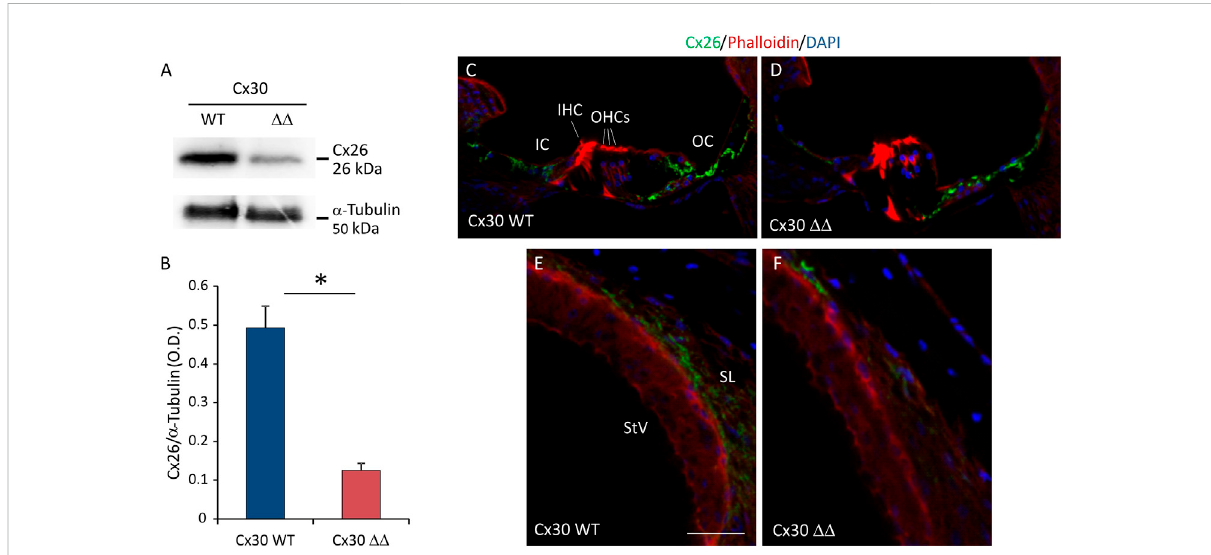
FIGURE 3 Cx26 expression in Cx30 ΔΔ -aging cochleae. (A) Representative western blot immunoreactive bands showing the expression of Cx26 in cochlearlysatesfromCx30WTandCx30 ΔΔ animalsat12monthsofage. (B) Histograms(mean±S.E.M.)representopticaldensityvaluesnormalized to α -tubulin. N = 8 cochleae/group. (C – F) Immuno fl uorescence analysis for Cx26 expression in Cx30 WT and Cx30 ΔΔ organ of Corti (C and D) and stria vascularis and spiral ligament (E and F) from 12 months of age cochleae. IHC: inner hair cell; OHCs: outer hair cells; OS: outer sulcus; IC: innersulcus;StV:striavascularis;andSL:spiralligament.Scalebar:50 μ m.N=4cochleae/group.Experimentswereperformedintriplicate.Asterisks indicate signi fi cant differences between groups from Student ’ s t-test (* p < 0.05).